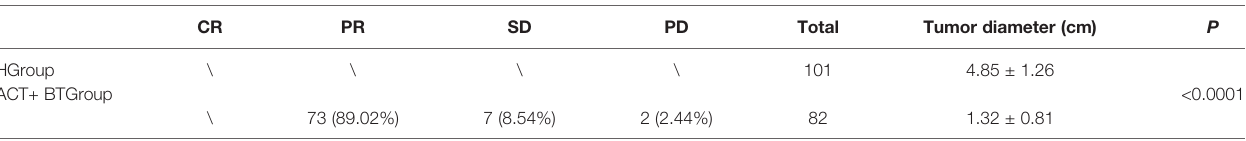
TABLE 2 | Comparison of therapy responses in patients.